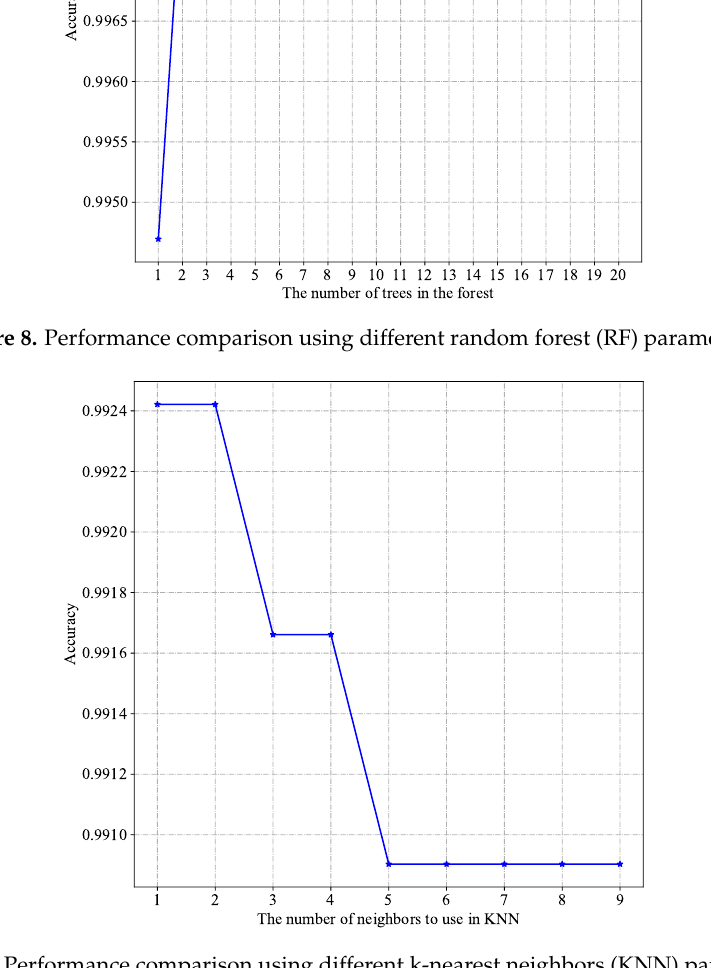
Figure 9. Performance comparison using different k-nearest neighbors (KNN)